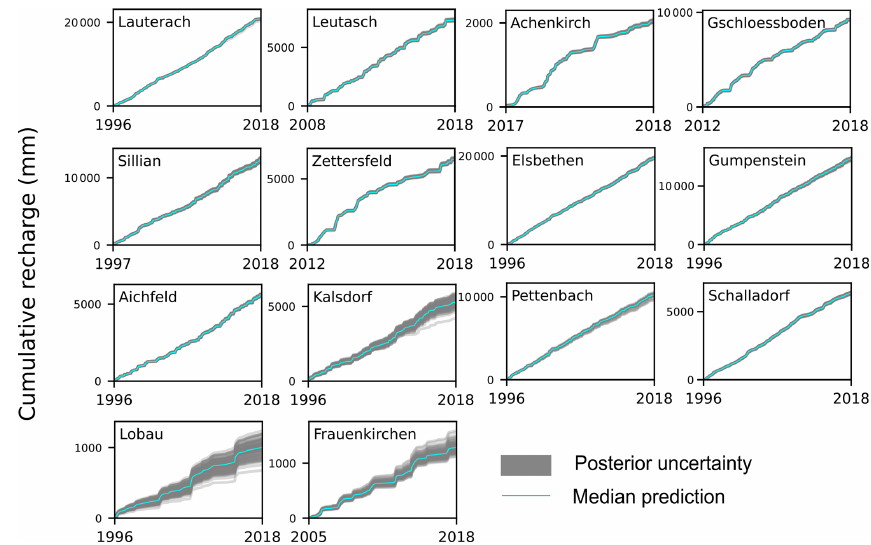
Figure 6. Median prediction and posterior uncertainty in the long-term estimation of cumulative recharge at 14 Austrian sites.